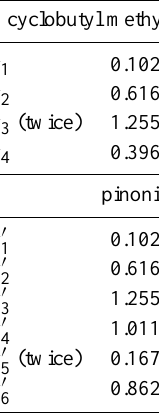
Table 2. Reaction rate constants for hydrogen atom abstraction from cyclobutyl methyl ketone (CMK) by a hydroxyl radical ( dices correspond to the carbon atom numbers in Fig. 1.